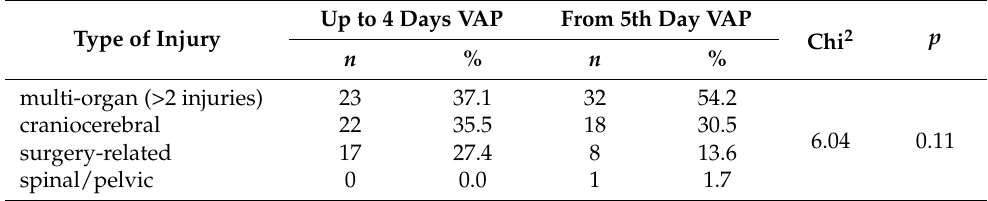
Table 5. The correlation between the type of injury and VAP contraction